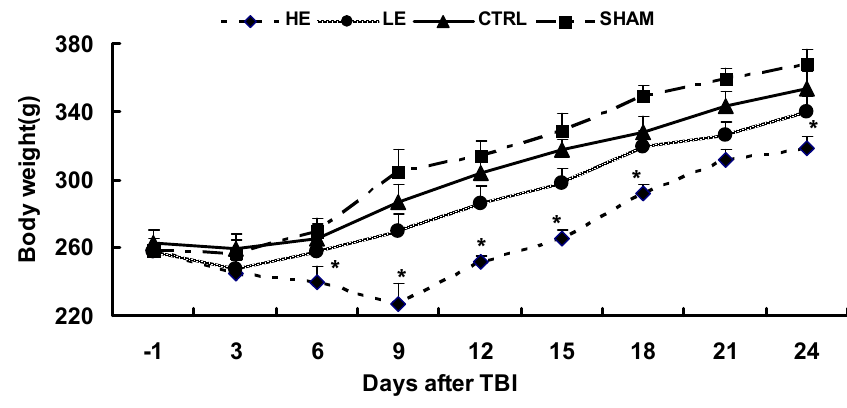
Figure 1. The effects of treadmill exercise on weight loss following TBI. No differences in initial, baseline body weights among the treatment groups were observed. All animals